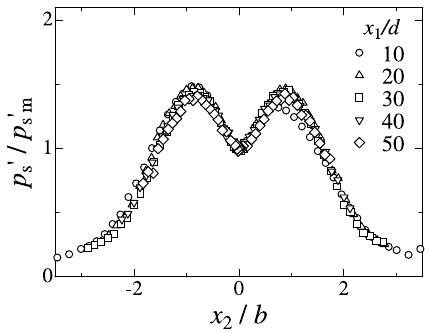
Fig. 14 Cross-streamwise profiles of the r.m.s static